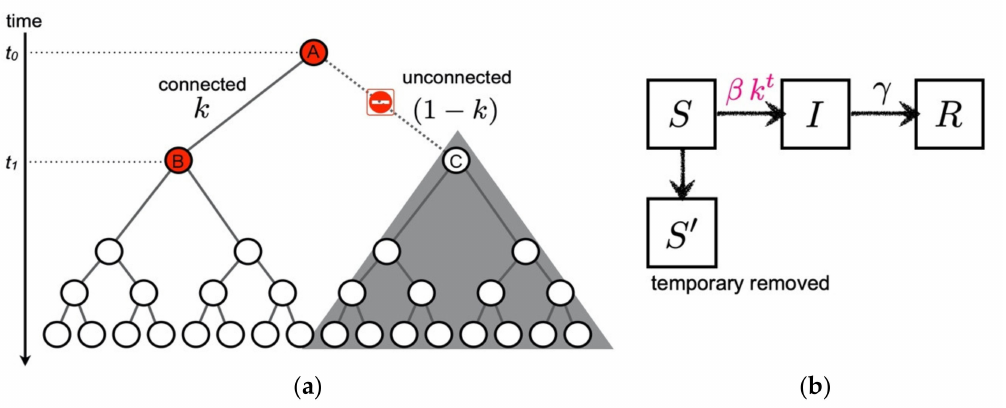
Figure 1. A suggested formula of the broken-link model. ( a ) Cartoon of the suppression of secondary infection in a transmission tree ( k = 1/2 case). When the transmission link from the primary infected individual A to the secondary candidate C is unconnected at time t 1 , subsequent transmissions starting from C are not generated as denoted by the shaded area. ( b ) Compartments of the broken- link model. The temporary removed compartment S (cid:48) is introduced due to the suppression of the secondary and higher-order transmissions. Contrary to the SIR model, the coupling between susceptible S and infected I becomes time dependent in the broken-link